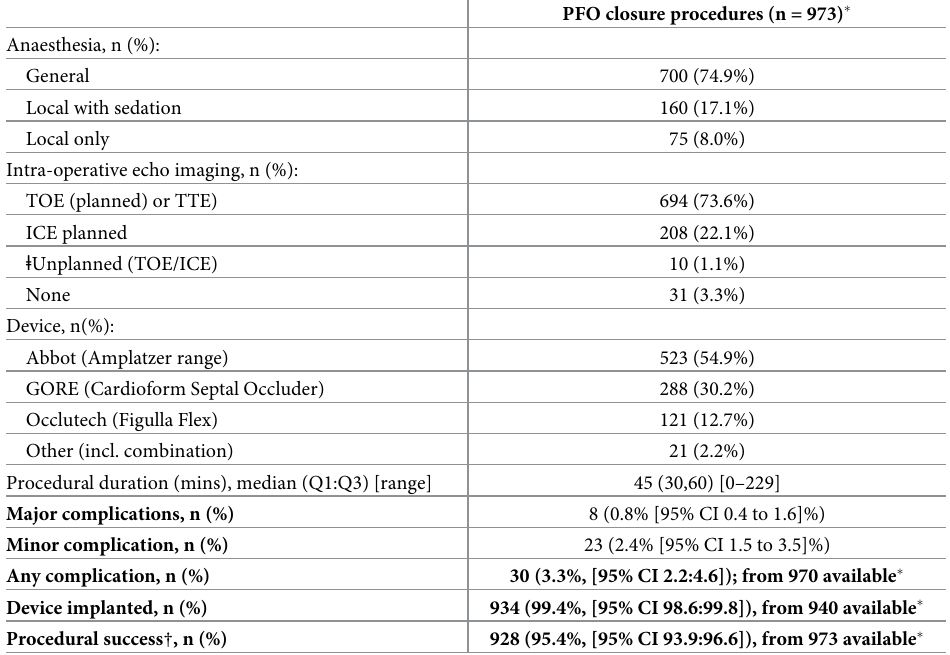
Table 2. Procedural details and in-hospital complications of people included in the registry.